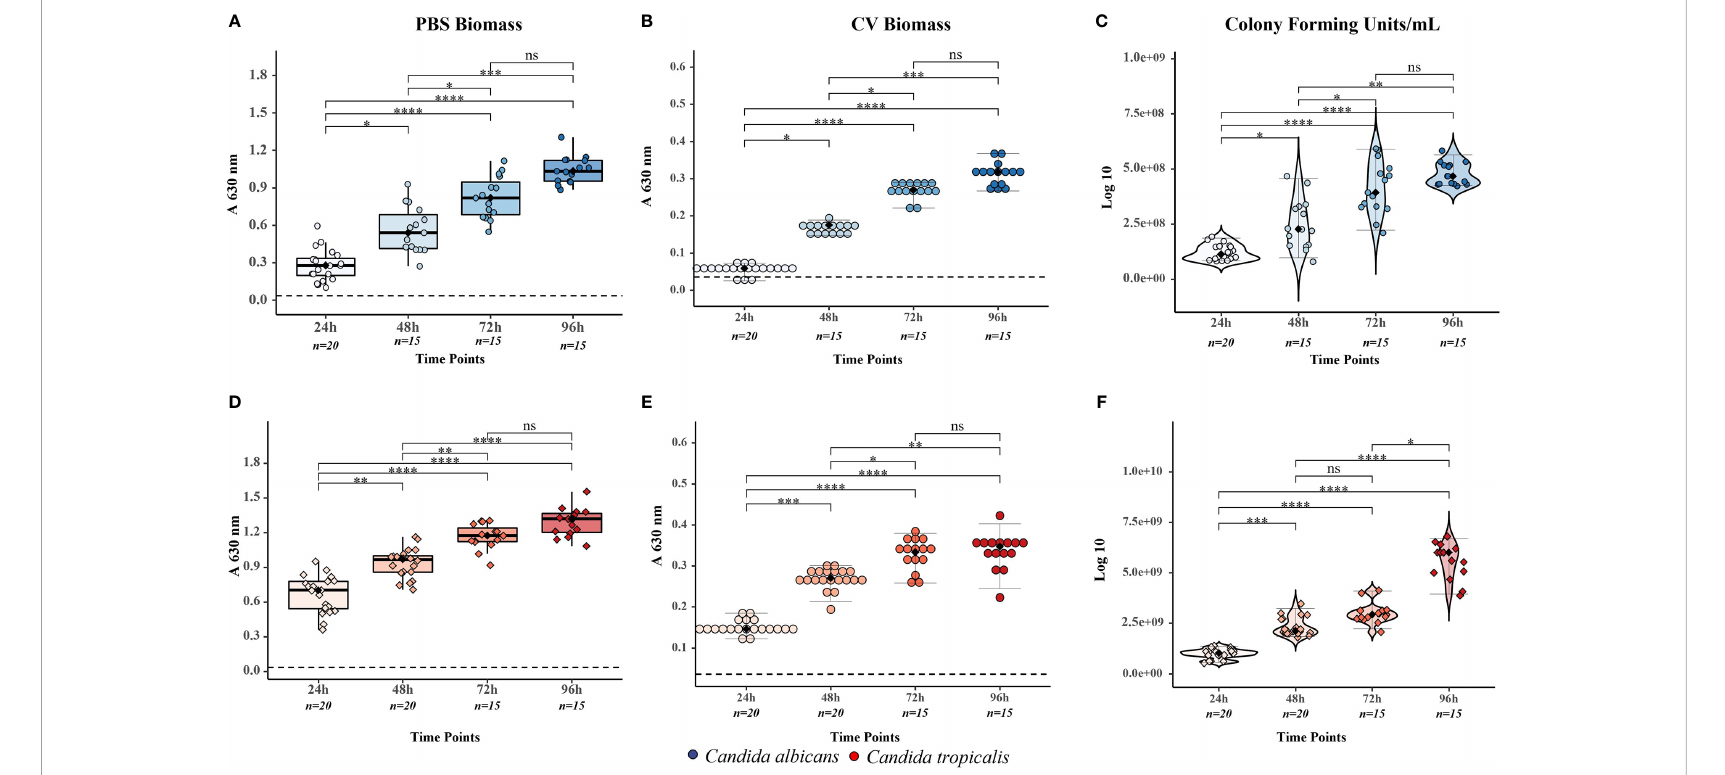
FIGURE 1 Evaluation of the bio fi lms formed by Candida albicans and Candida tropicalis during the speci fi ed time window (24, 48, 72, and 96 h) through the biomass and viability assays. Bio fi lm biomass was evaluated through two methodologies of optical density measurement, while viable cells within the bio fi lm were analyzed through colony-forming unit counting to describe the number of viable microorganisms. All these results were grouped and plotted for each species, where color dots represent the individual result of each assay (blue dots for (C) albicans and red dots for (C) tropicalis), overlaid box plots cover the upper and lower interquartile ranges, whiskers extend to extreme datapoints, and the black diamond represents the median (data shown in Table 1). (A) Biomass of (C) albicans bio fi lm by phosphate-buffered saline (PBS) suspension method, (B) biomass of (C) albicans bio fi lm by crystal violet (CV) staining method, (C) viability of (C) albicans bio fi lm by colony-forming unit counting, (D) biomass of (C) tropicalis bio fi lm by PBS suspension method, (E) biomass of (C) tropicalis bio fi lm by CV staining method, and (F) viability of (C) tropicalis bio fi lm by colony-forming unit counting. The illustrated statistical analysis between time in biomass and viability assays for each Candida species was realized through post-hoc Dunn ’ s test using a Benjamini – Hochberg adjustment (all data are shown in Supplementary Material Information S1), more speci fi cally *p < 0.05; **p < 0.01; ***p < 0.001; ****p < 0.0001; ns, non signi fi